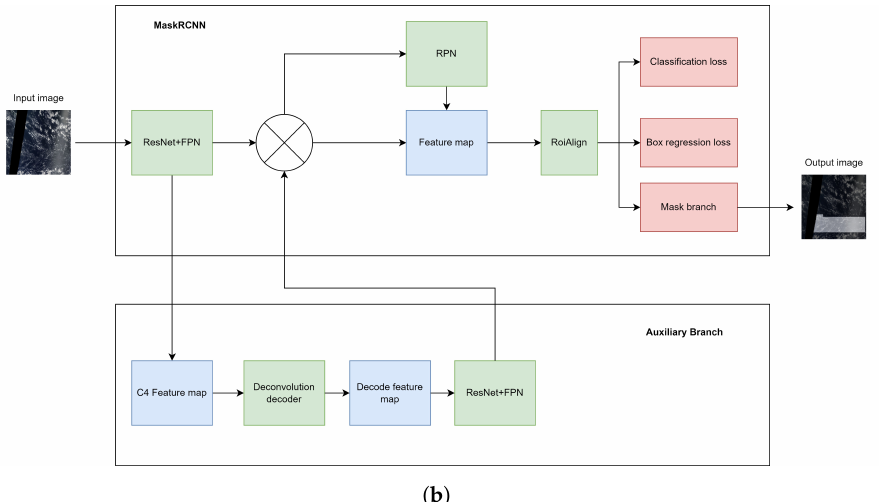
Figure 2. The architecture of the two designs. ( a ) The architecture of CloudRCNN (auxiliary loss); ( b ) The architecture of CloudRCNN (feature